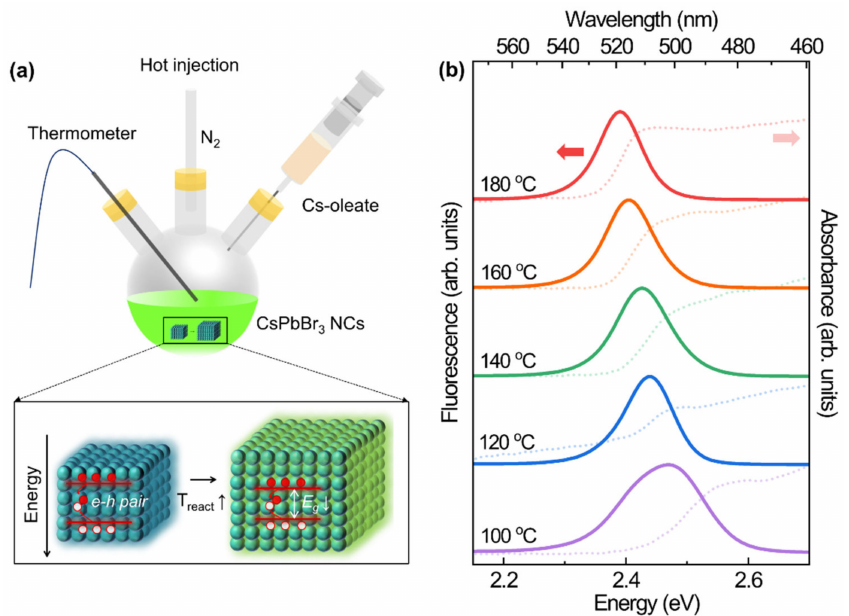
Figure 1. Synthesis and the optical properties of CsPbBr 3 perovskite nanocrystals (NCs): ( a ) Schematic illustration of the hot injection method and band diagram within different-sized CsPbBr 3 NCs; ( b ) absorption and fluorescence spectra for the CsPbBr 3 perovskite NCs prepared at different reaction